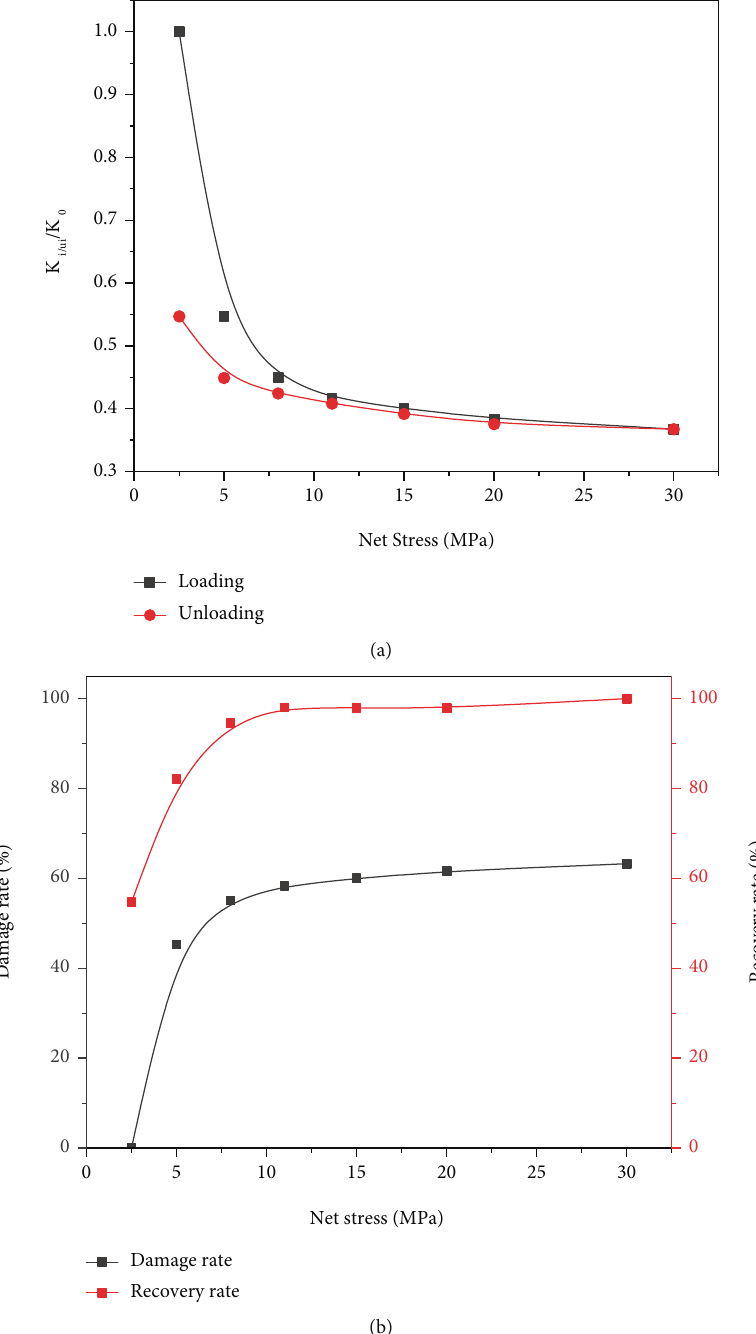
Figure 2: Variable con fi ning pressure: (a) the relation between dimensionless permeability and net stress; (b) permeability damage and recovery rate under di ff erent net